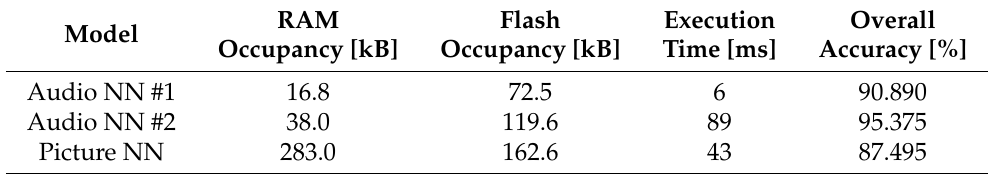
Figure 4. Confusion matrices showing the performance of the models on the test set: ( a ) audio NN #1, ( b ) audio NN #2, and ( c ) picture NN. Table 4. Hardware performance of the ML